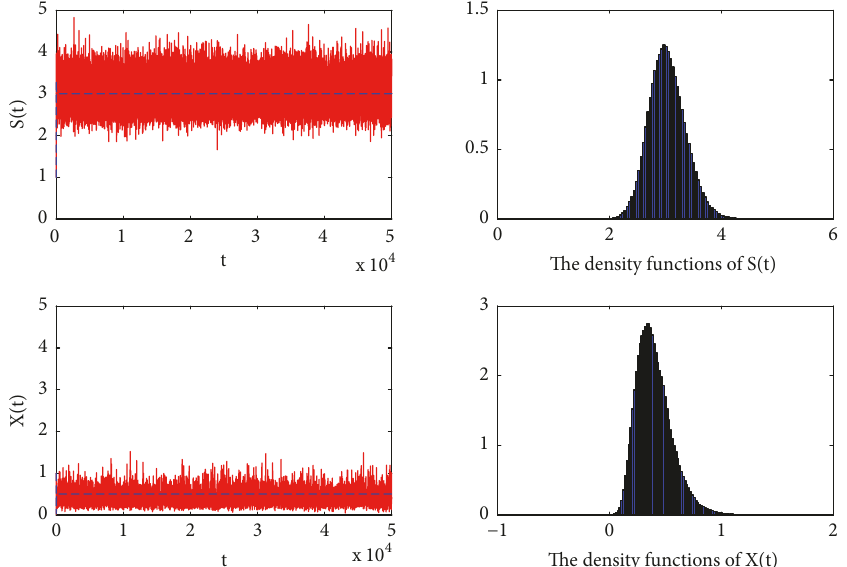
Figure 2: (𝑆(𝑡),𝑋(𝑡)) has a stationary distribution. In the left, the red lines represent the solution of system (2), and the blue lines represent the solution of the corresponding undisturbed system. The pictures on the right are the density functions of system (2).